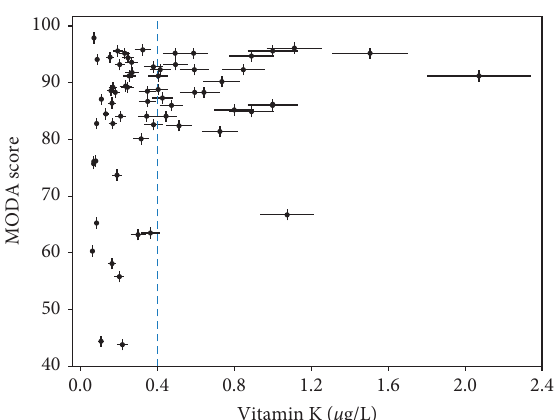
Figure 1: MODA scores vs. vitamin K1 plasmatic levels. The dispersion of the values tends to decrease as the vitamin K1 concentration increases (see also Table S1 in the Supplementary Material). This leads to larger mean MODA scores for higher concentrations of the vitamer, in particular for concentrations above 0.400 μ g/L (blue dashed line).